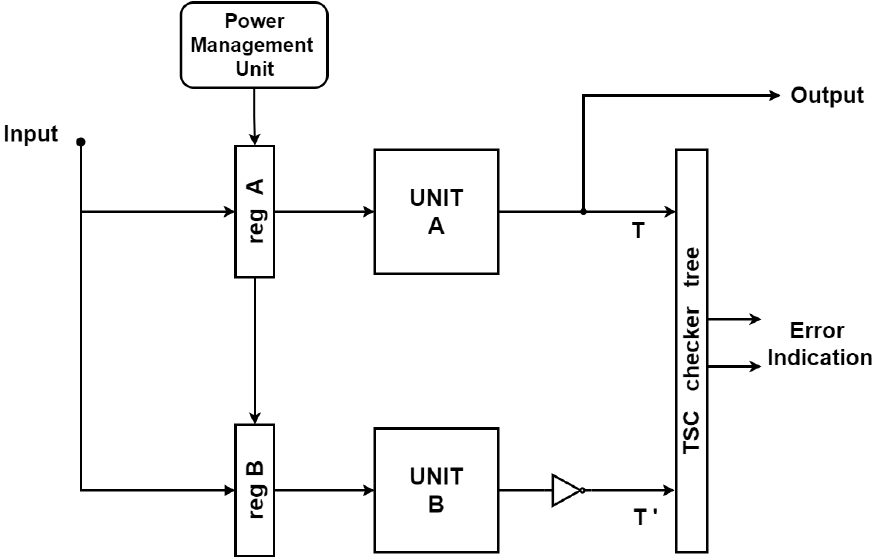
Figure 2. Formal architecture of an on-line testable system with a dynamic power management